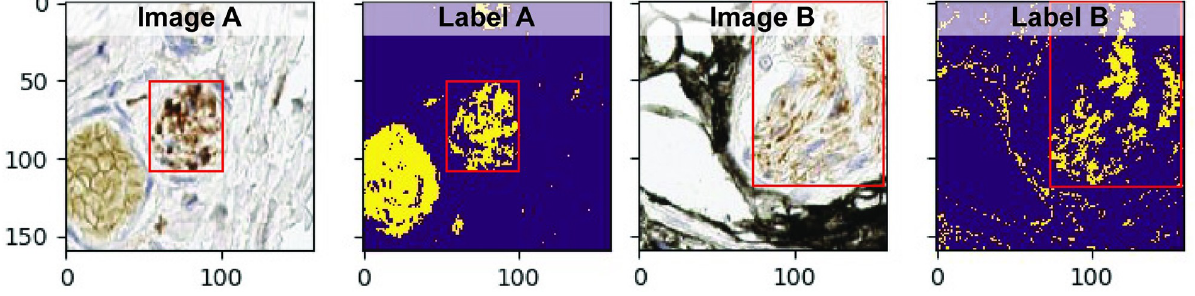
Fig 10. Excluded positive training data samples due to label artifacts from the colour filter. The red box surrounds the actual nerve.